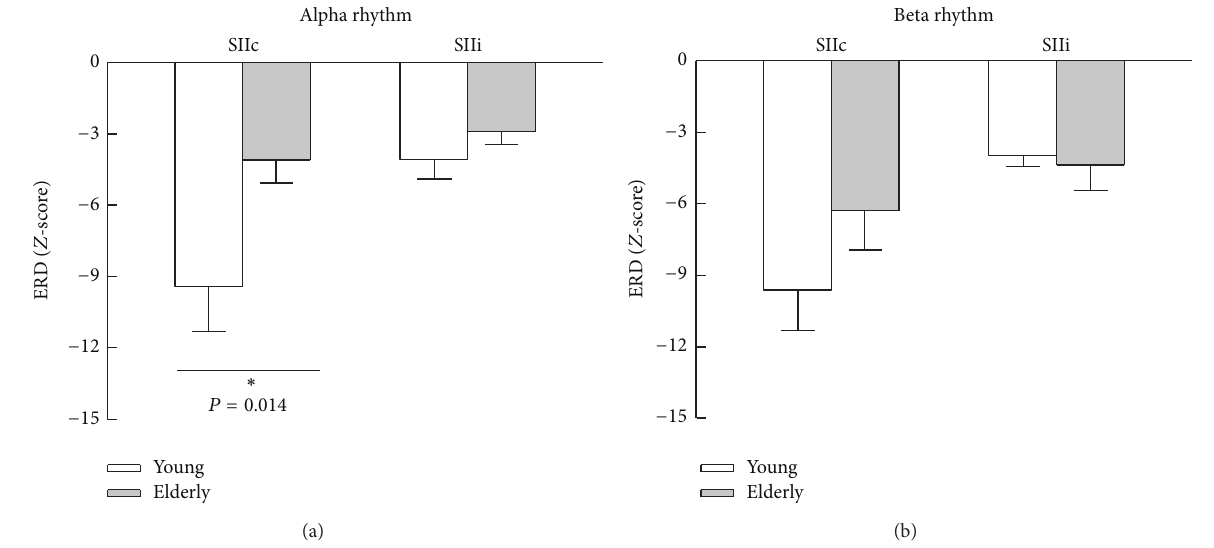
Figure 4: Mean values of stimulus 1-induced ERD peaks for alpha and beta rhythms. The bar above each column indicates the SEM.